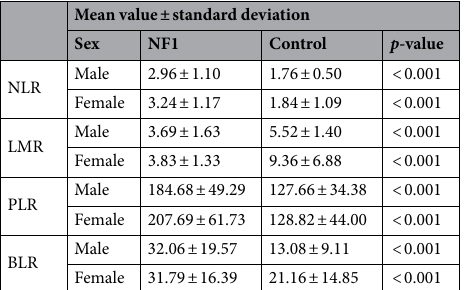
Table 2. Comparison of NLR, LMR, PLR and BLR between NF1 patients and